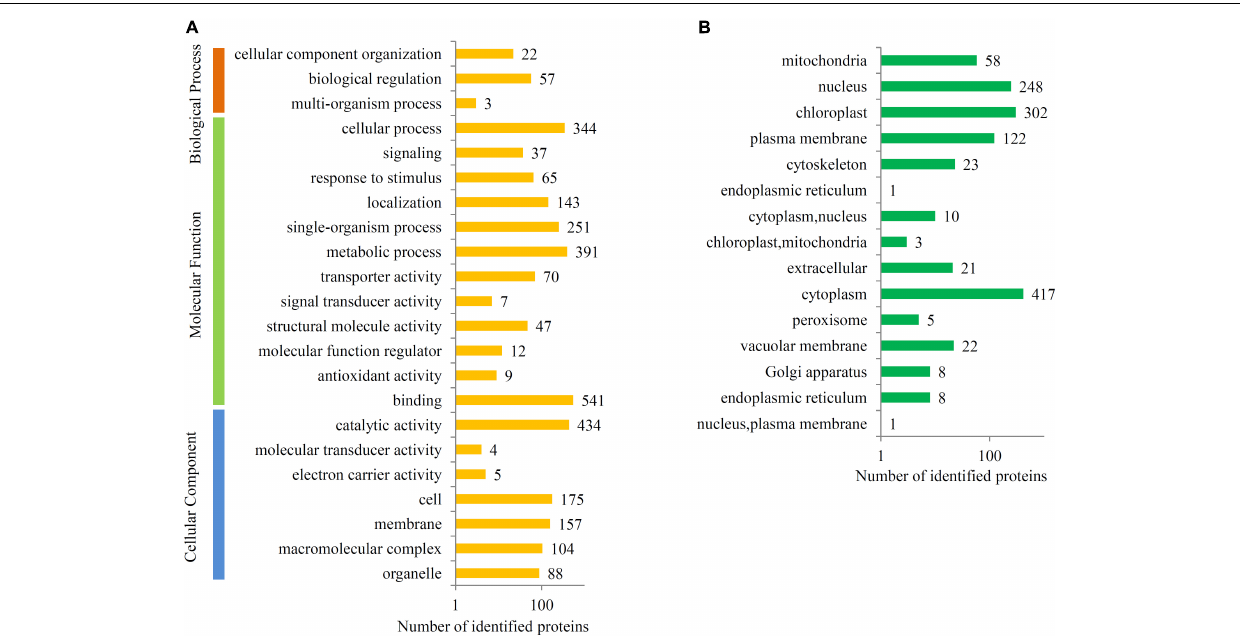
including 417 cytoplasm proteins, 302 chloroplast proteins, 248 nucleus proteins, and 122 plasma membrane proteins ( Figure 4B